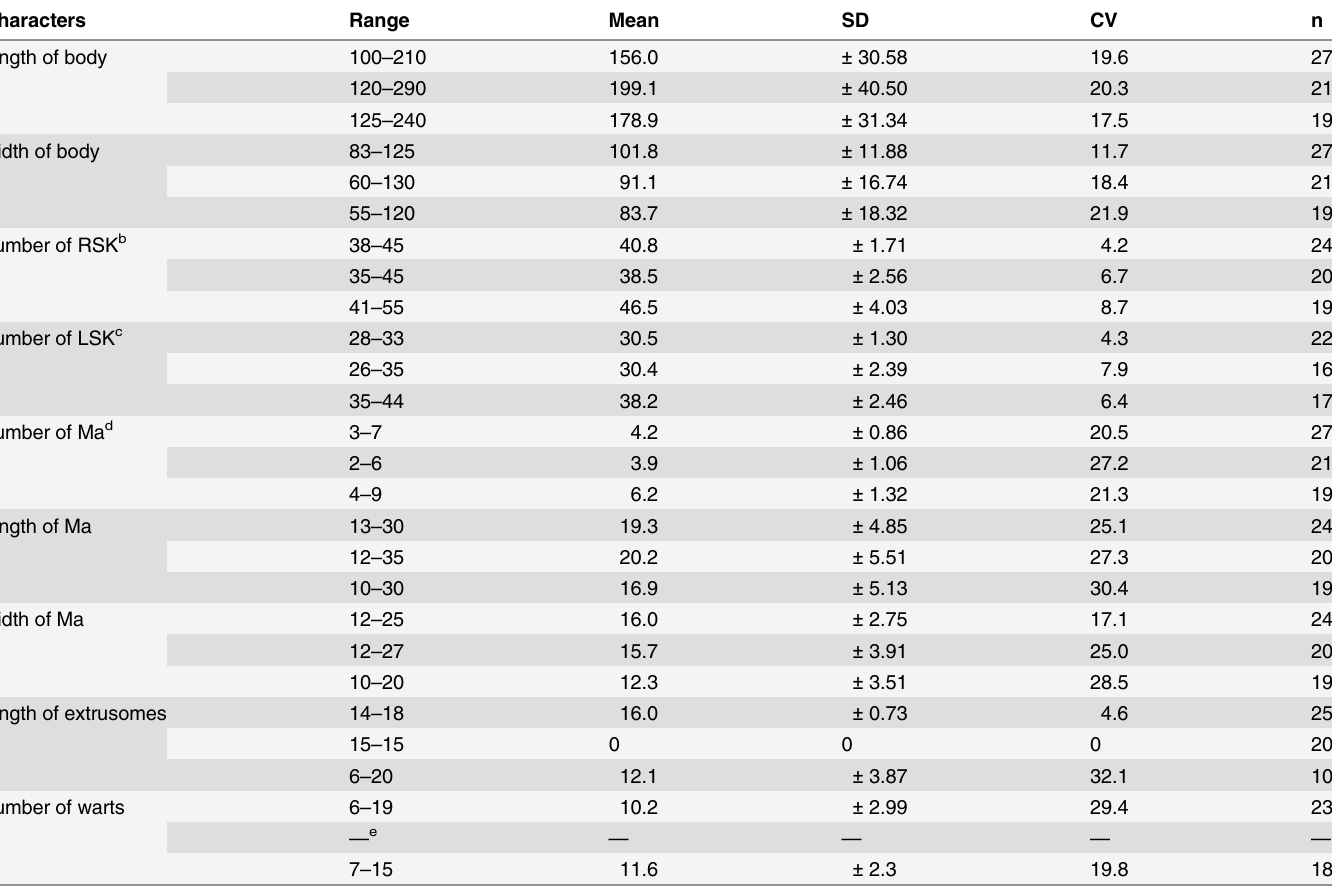
Table 2. Morphometric data a of Kentrophyllum verrucosum (1st line), K . bispinum n. sp. (2nd line) and K . strumosum n. sp. (3rd line). Characters